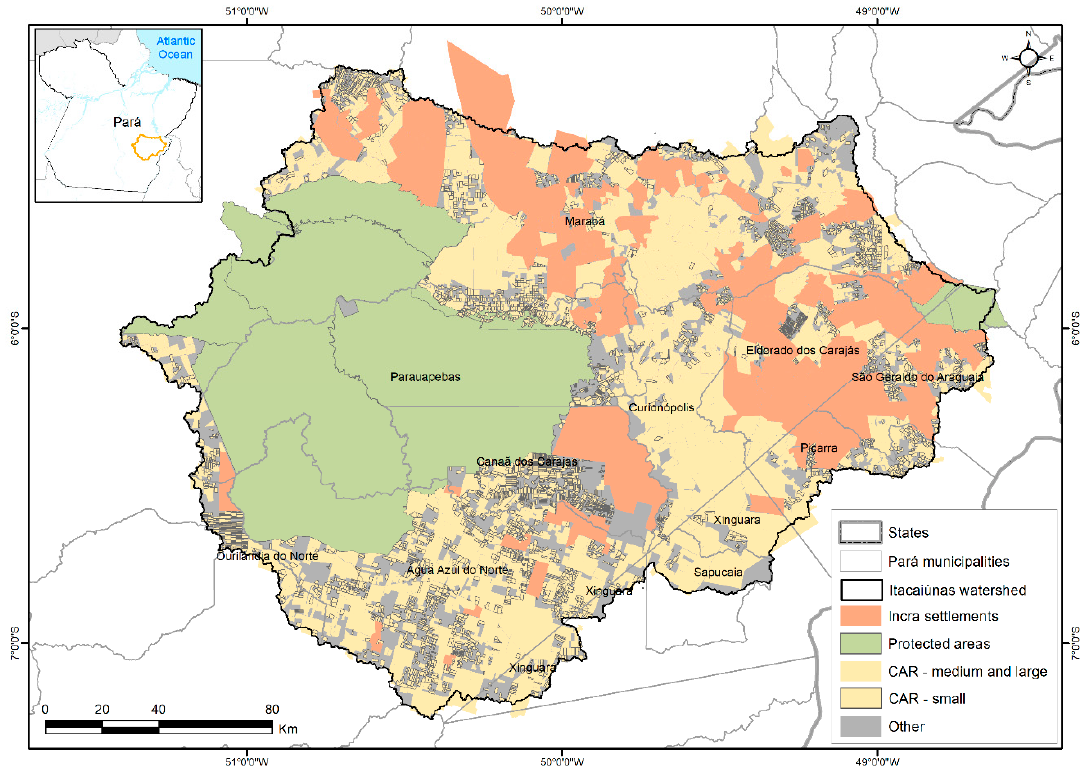
Figure 2. Land tenure status in the Itacaiúnas watershed.